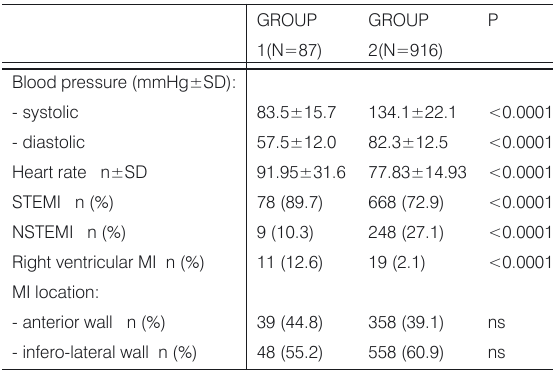
Figure 1. Clinical endpoints. Table 2. Clinical characterictics at the moment of